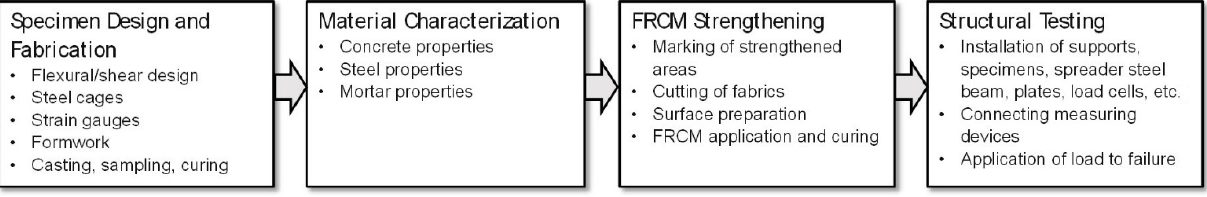
Figure 1. Activities of the experimental program.